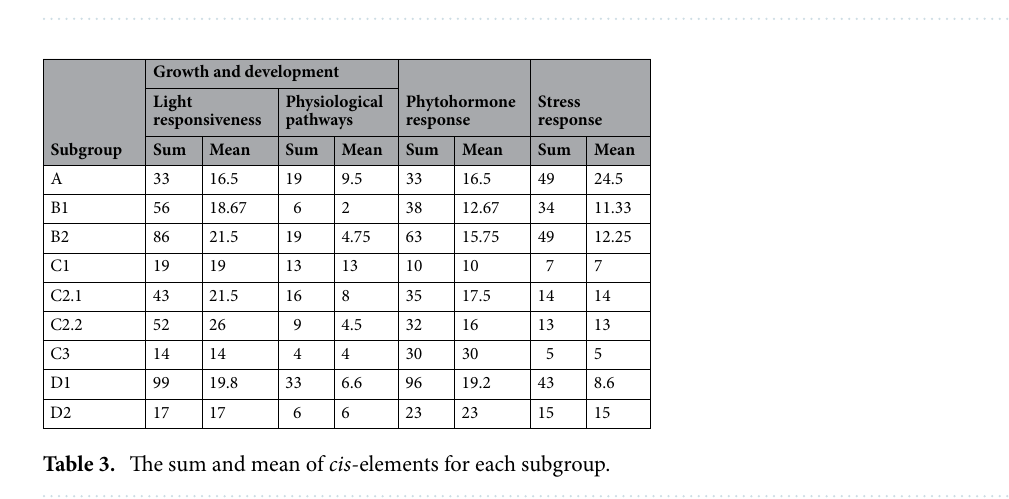
Figure 5. The schematic distribution of motifs for Dof genes among spinach, Arabidopsis and sugarbeet. Figure was made by the MEME program (http:// meme- suite. org/) and TBtools-1.082.